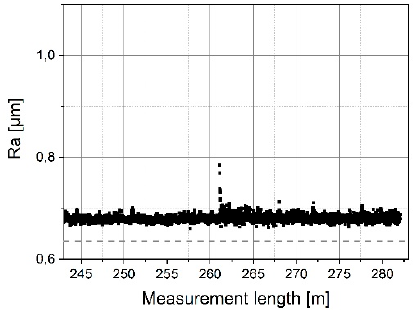
Figure 21. Determined average roughness values for a traverse length of 40 m after a wear measurement length of 243 m on the roughness standard RN6531.